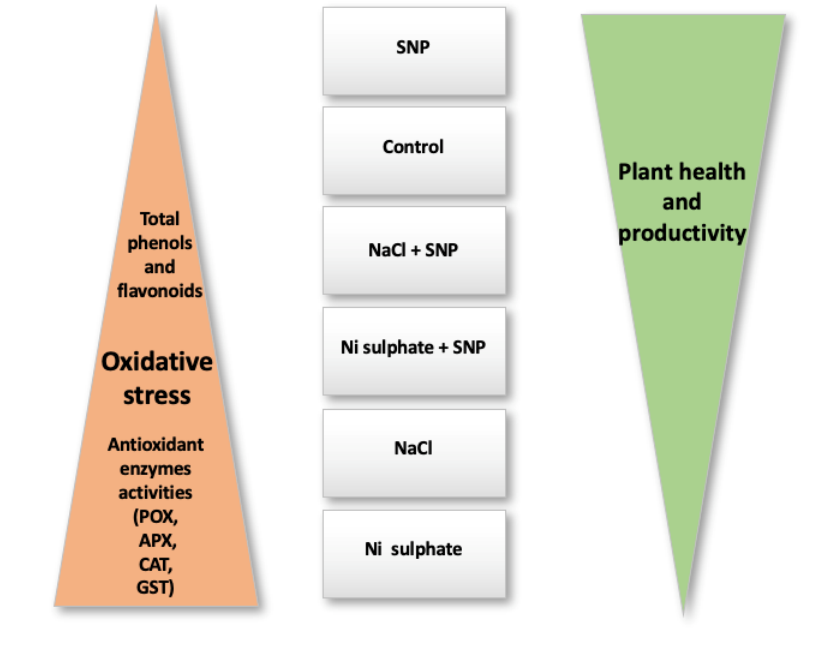
Figure 3 Simplified schematic diagram summarizing the impact of sodium nitroprusside (SNP), salt stress, and Ni toxicity on plant health, oxidative status, secondary metabolites, and antioxidant enzyme activities. SNP = 0.4 mM (the most effective